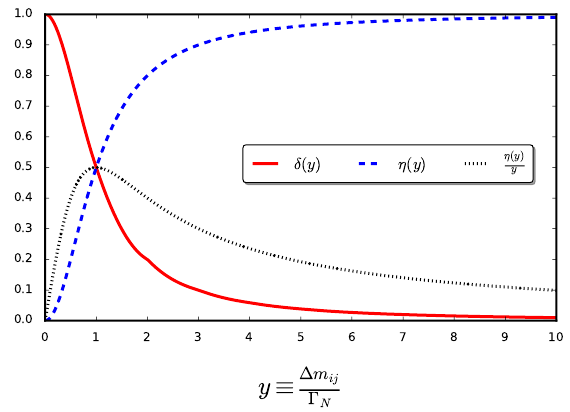
Figure 4 . Solid line (online red) overlap function (cid:14) 12 . Dashed line (online blue) (cid:17) ( y ) function. Dotted line (online black) (cid:17) ( y ) =y